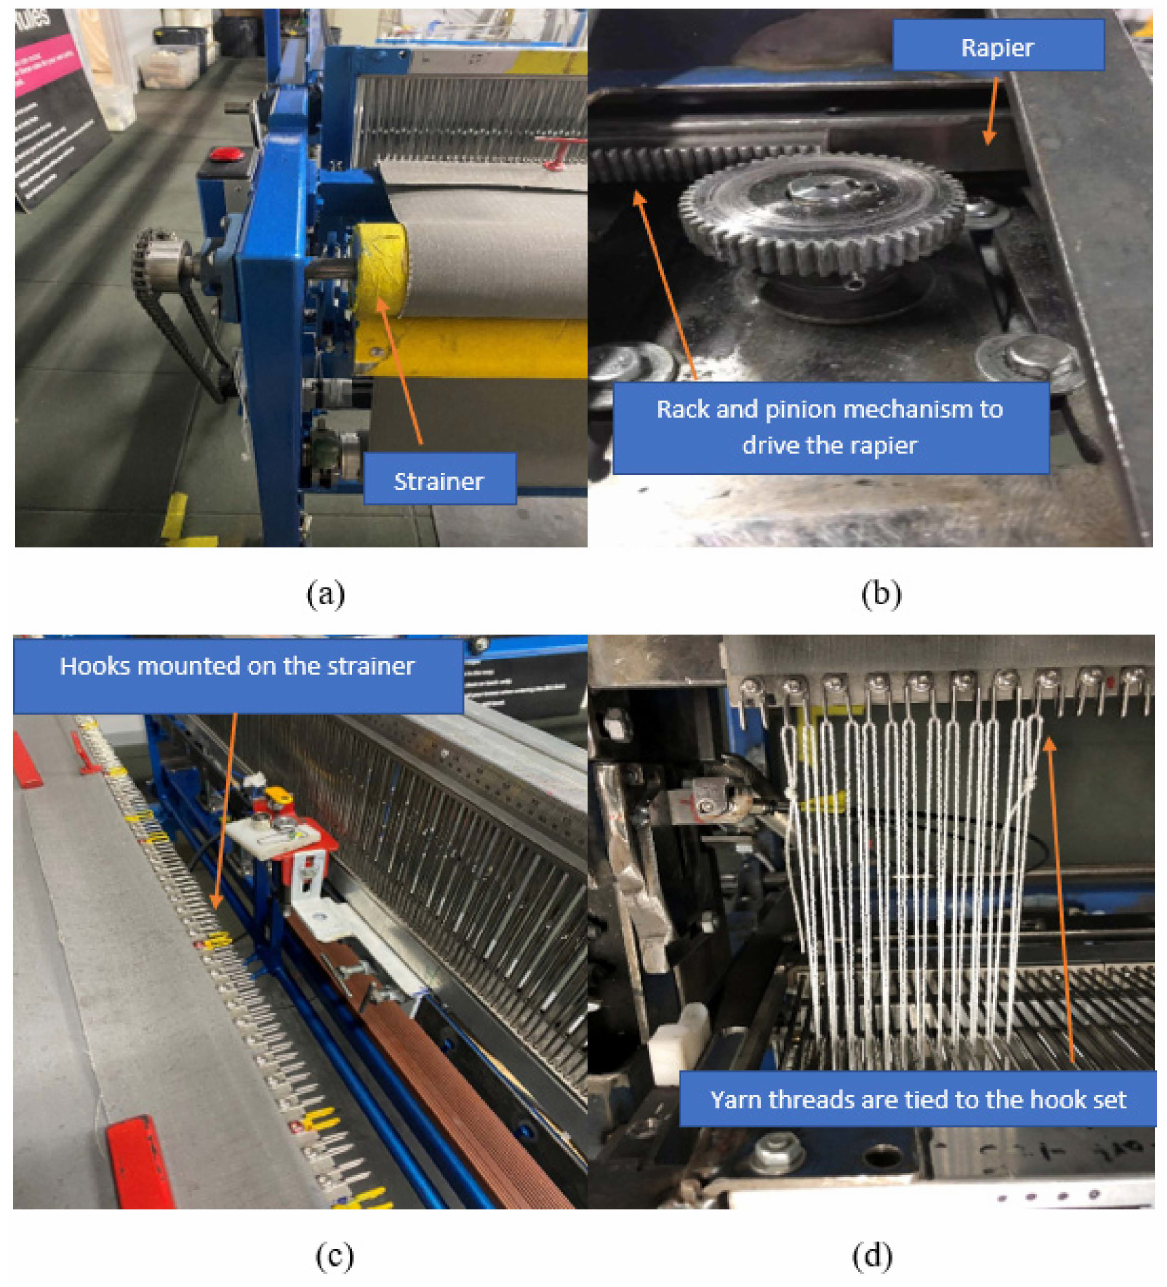
Figure 1. Hooks are mounted on a strainer: ( a ) The strainer rotates to wind the trampoline mattress during the weaving process, ( b ) rapier is driven by a rack and pinion mechanism, ( c ) hooks